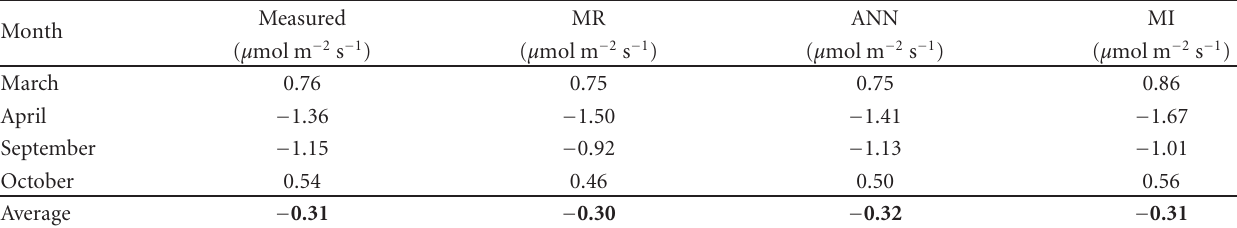
Table 3: Monthly averages of the measured CO 2 flux and of the CO 2 flux gap filled MR, ANN, MI for equinoctial season.